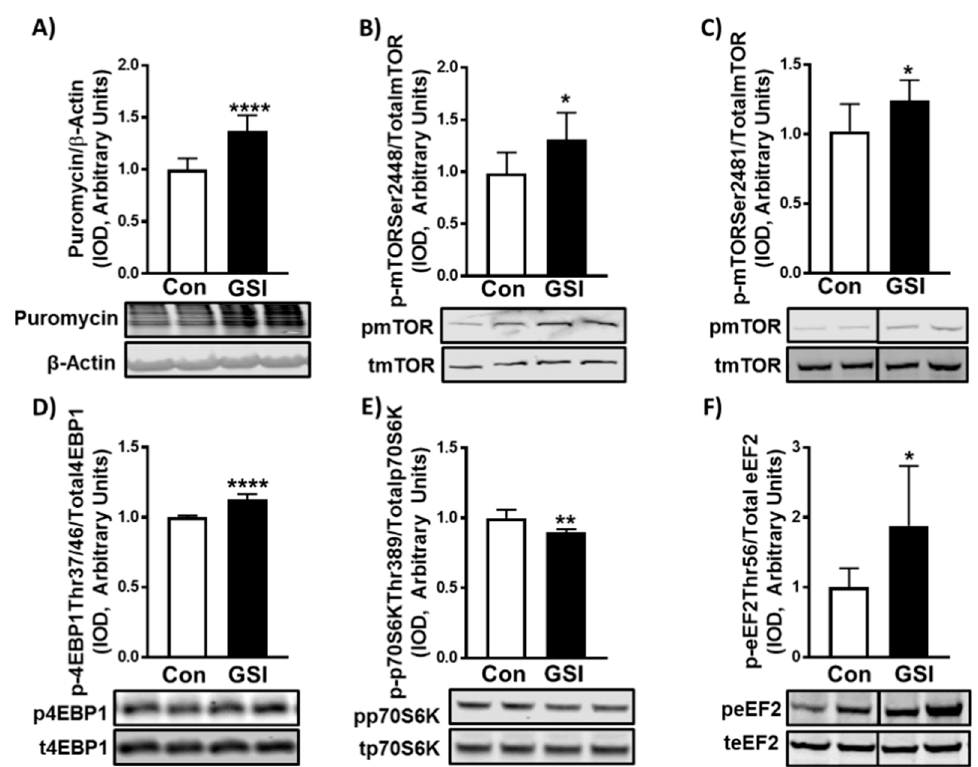
Figure 3. GSI increases protein synthesis and mTOR signaling in C2C12 myotubes. ( A ) Puromycin/ β - Actin; ( B ) Phospho (p)-mTOR Ser2448/Total mTOR; ( C ) p-mTOR Ser2481/Total mTOR; ( D ) p-4EBP1 Thr37/46/Total 4EBP1; ( E ) p-p70S6K Thr389/Total p70S6K; ( F ) p-eEF2 Thr56/Total eEF2 expression (Integrated optical density, IOD) in 96-h myotubes treated with or without 4 µm γ -secretase inhibitor (GSI) every 12 h. Thirty minutes prior to collection all cells were treated with 1 µm puromycin. For representative images: lanes 1 and 2 are Con; lanes 3 and 4 are GSI. Data were analyzed using a Student’s T-test. * p ≤ 0.05 vs. Control (Con); ** p < 0.01 vs. Con; **** p < 0.0001 vs. Con ( n = 3